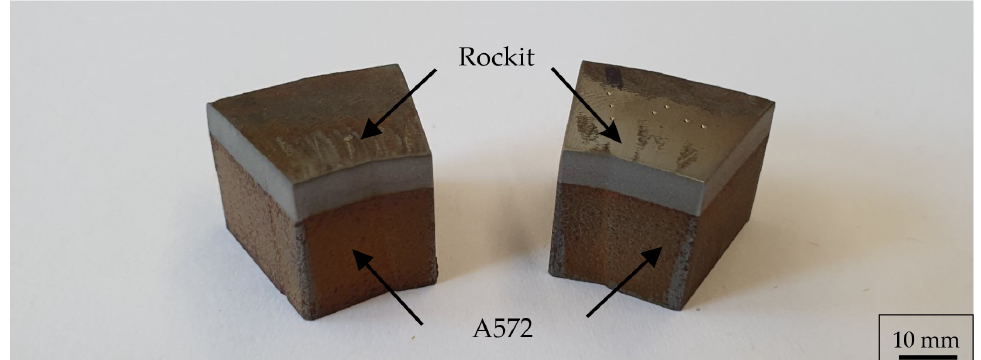
Figure 8. Specimens after corrosion